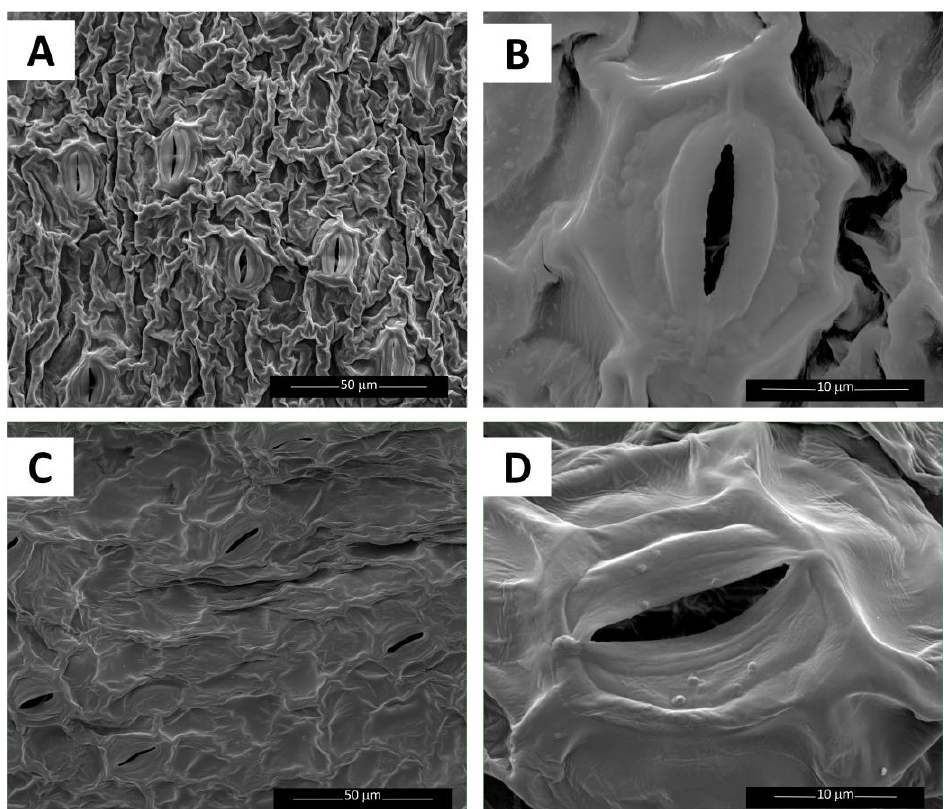
Figure 3. Scanning electron microscopy (SEM) images of Lemna minor fronds; upper leaf surface ( A ) and stomata ( B ) of 80 – control; upper leaf surface ( C ) and stomata ( D ) of 80 – AgNP.